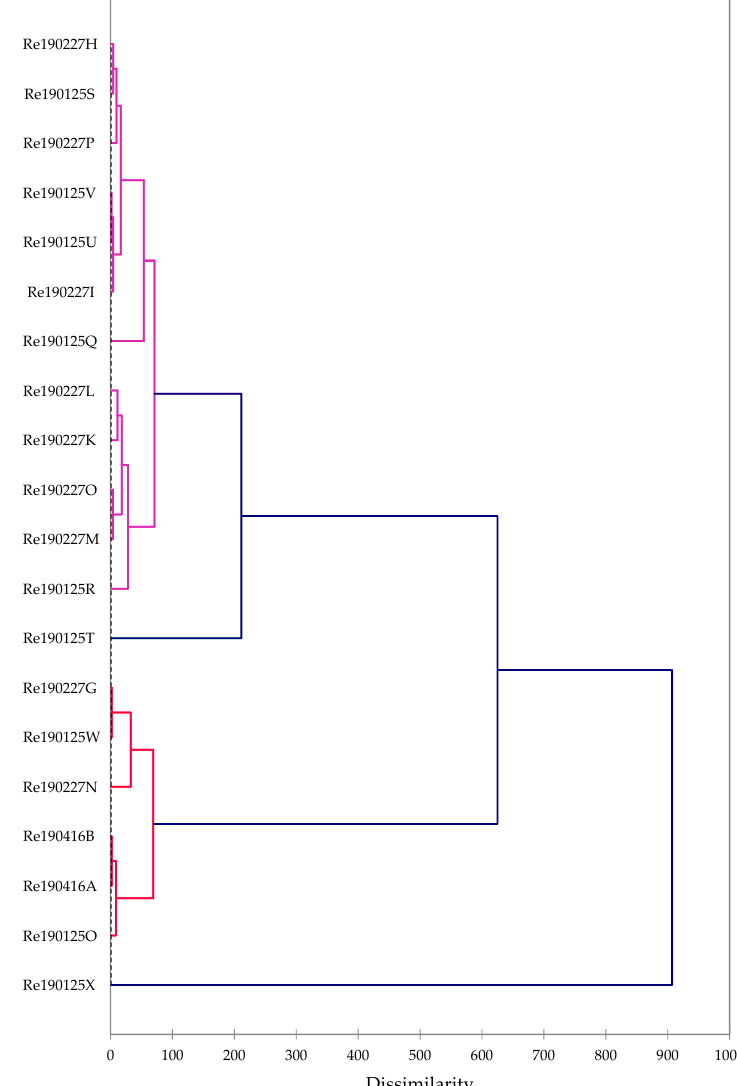
Figure 2. Dendrogram obtained from the agglomerative hierarchical cluster analysis of 20 Boswellia dalzielii oleogum resin essential oil compositions from Burkina Faso.